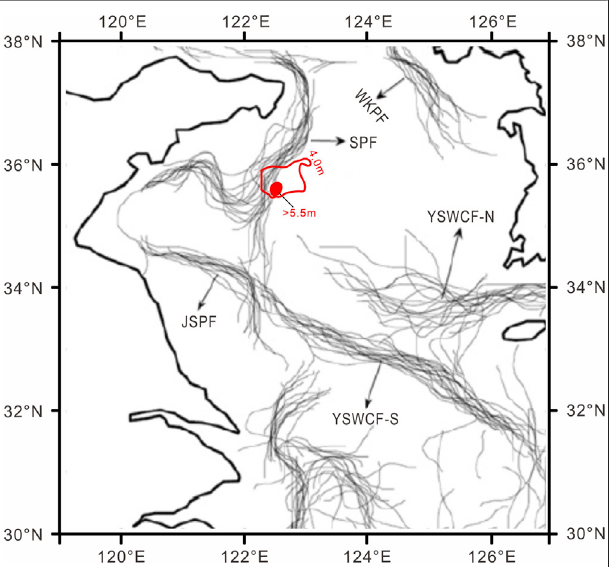
FIGURE 7 | Central frontal lines in February for an 18 year period (1985 – 2002) (Wang F. et al., 2012), and the thickest mud patch since 7 ka (red area and contour). SPF: Shandong Peninsula Front, JSPF: Jiangsu CoastalFront,WKCF:WesternKoreanCoastalFront,YSWCF-N:Yellow Sea Warm Current Front-North, YSWCF-S: Yellow Sea Warm Current Front-